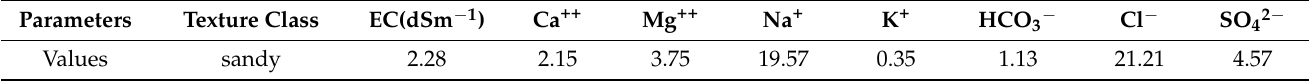
Table 1. Some physical and chemical analyses of the orchard soil.